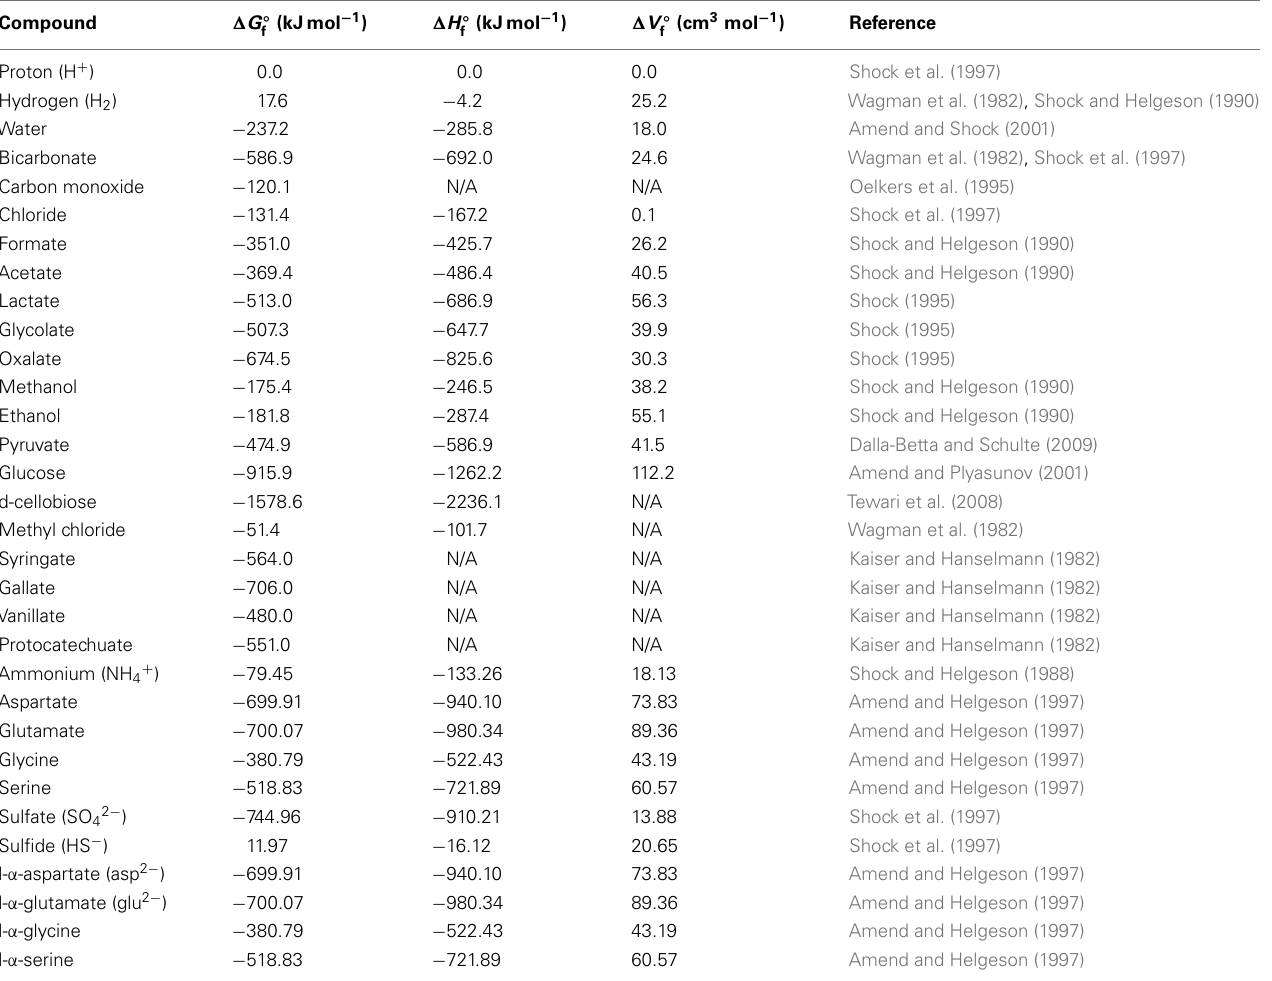
Table 2 |Thermodynamic data of aqueous educts and products under standard conditions (N/A = no available published